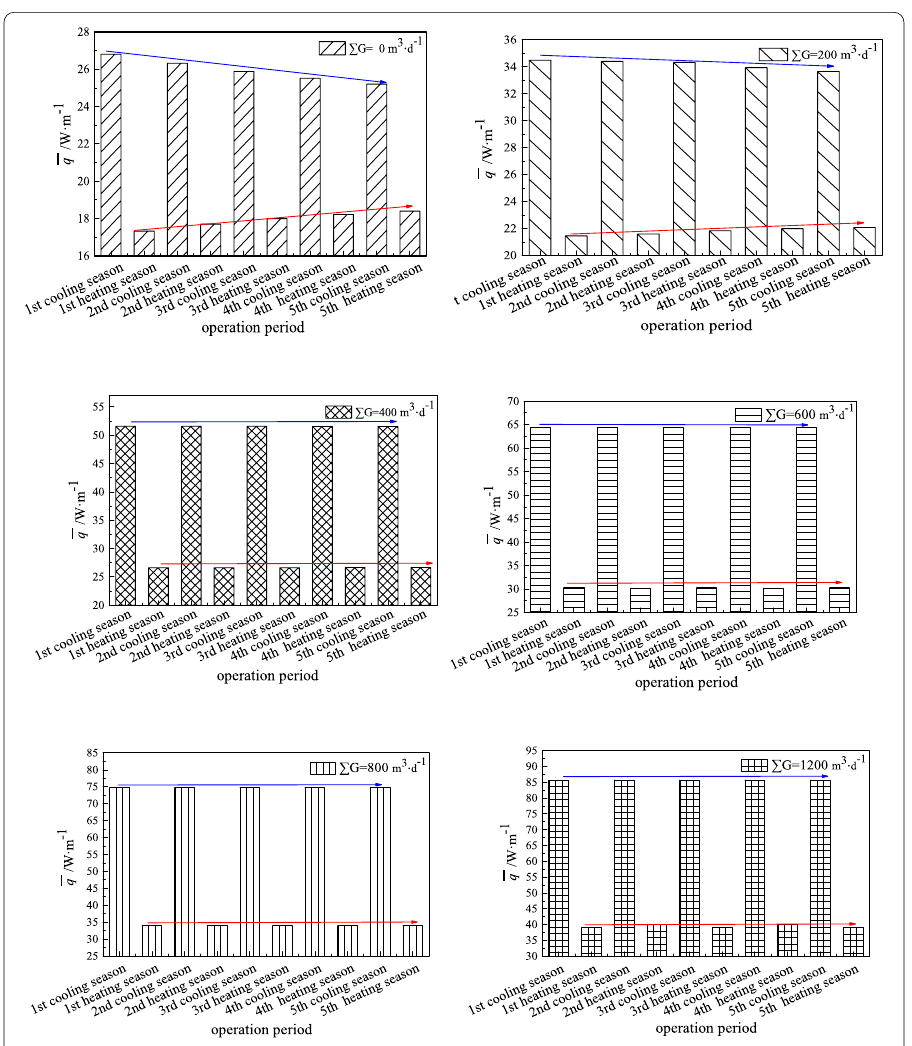
Fig. 14 Average heat transfer rates per unit borehole depth of BHEs ( ¯ q over the whole operation period under different pumping–injection flow volume ∑ G : a ∑ G ∑